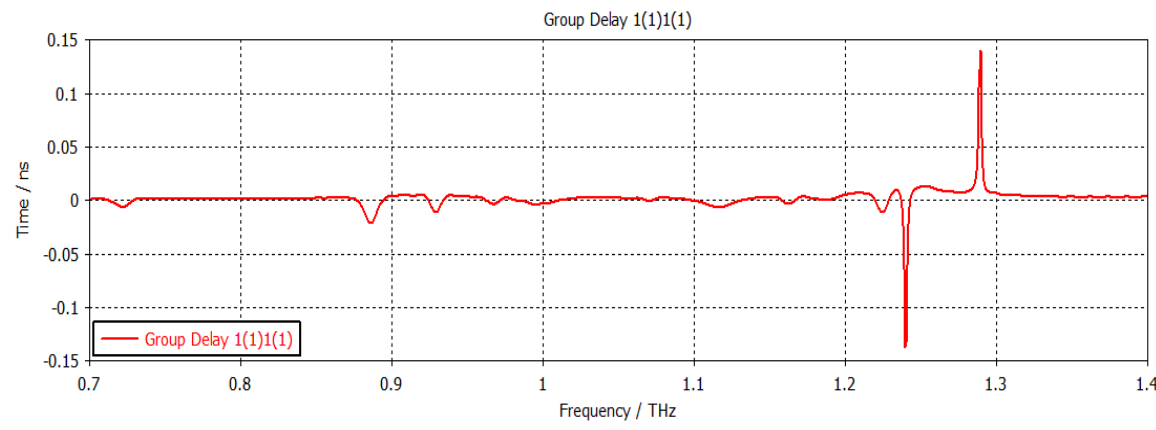
Figure 2. S-parameter results.